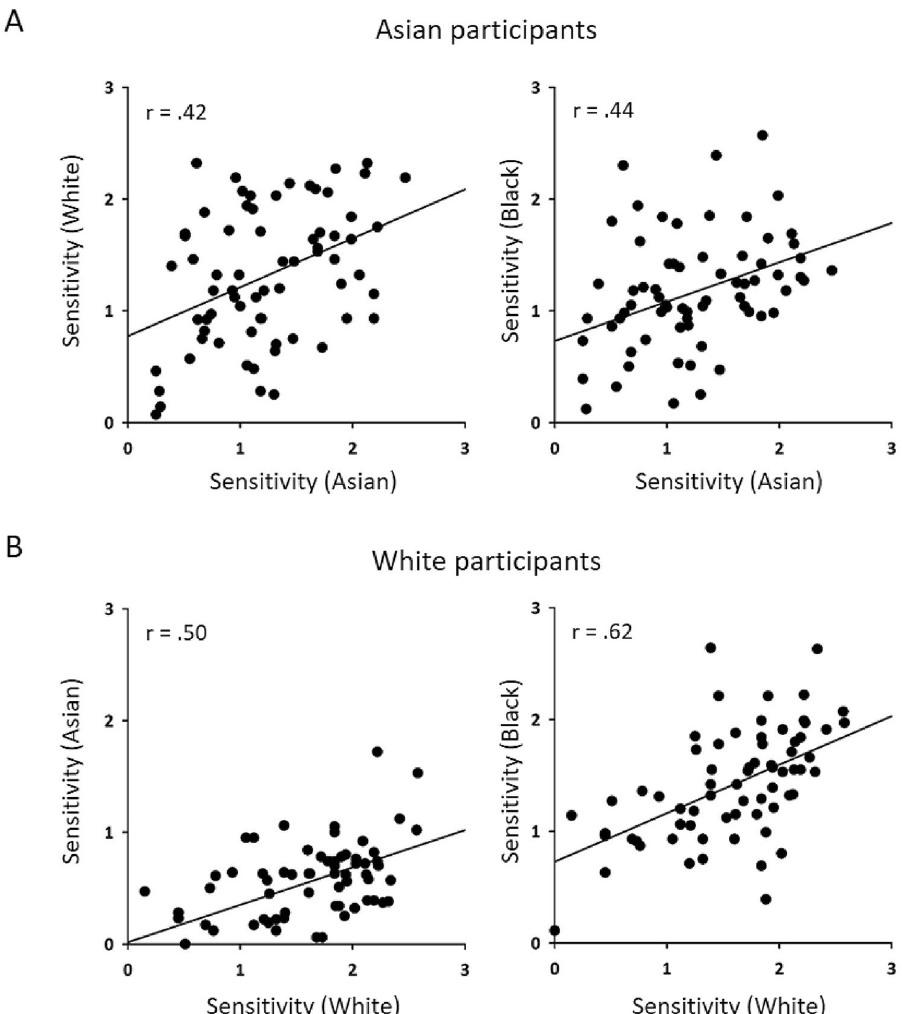
Figure 2. Correlation between d’ values between different face matching tasks in Asian and White participants. Significant positive correlations were found for each matching task for both own-race and other-race faces suggesting that performance on own-race faces predicted performance on other-race